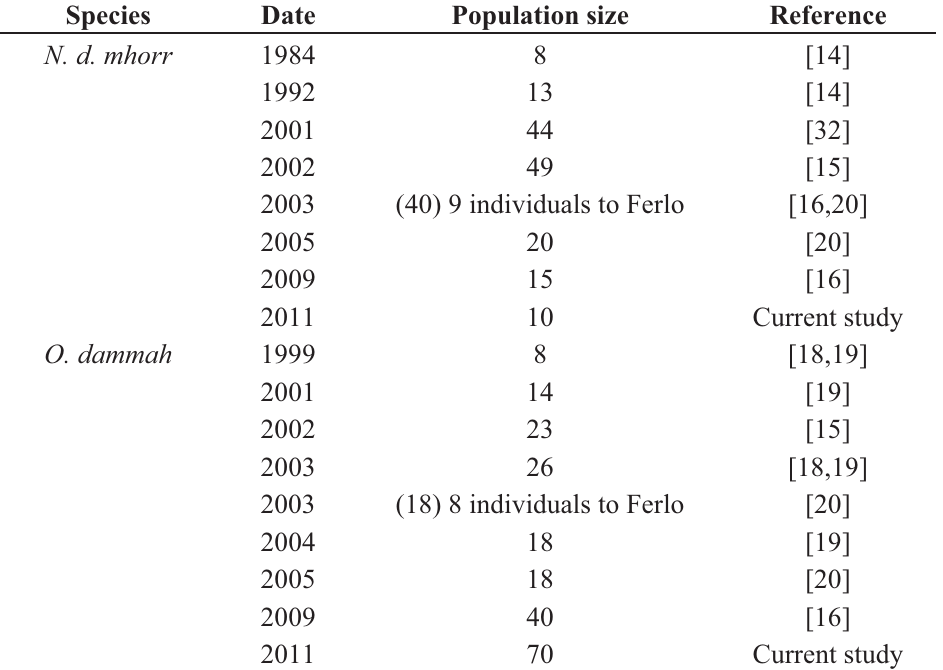
Table 1. Evolution of the Mohor gazelle and Scimitar-horned oryx populations at RF Guembeul since their respective years of reintroduction (1984 and 1999) according to published information. References are